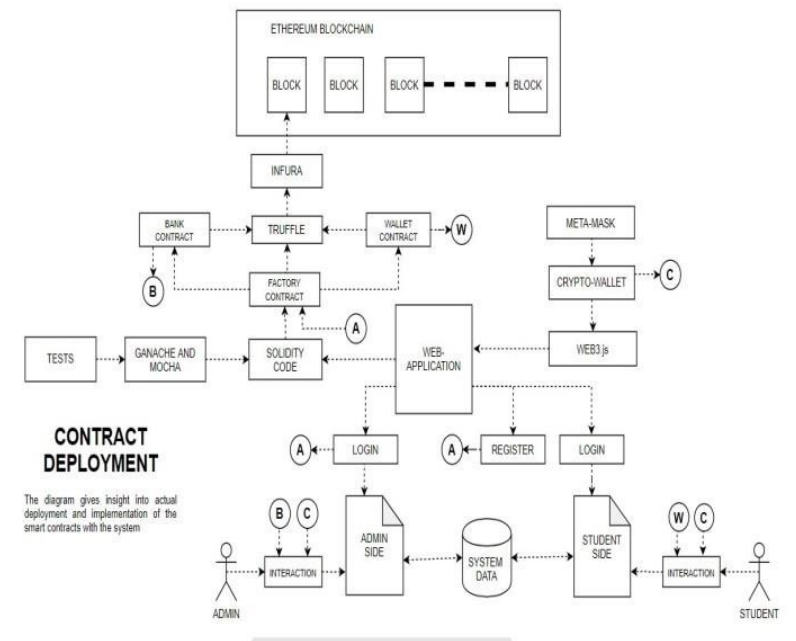
Figure 4. Overview of Cibil score’s importance. Figure 5. Public cryptocurrency